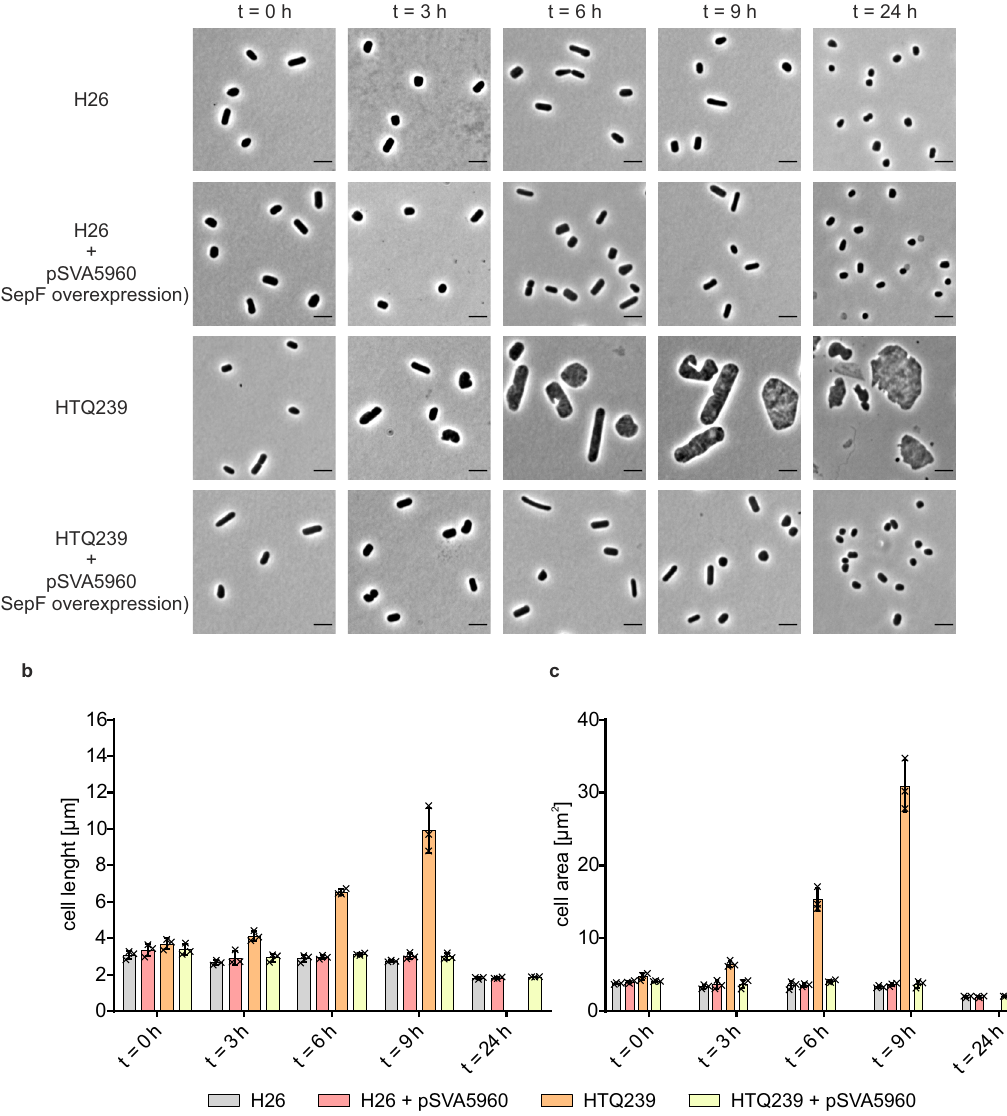
Fig. 6 Cell shape analysis of H26 and HTQ239 during sepF overexpression in the absence of tryptophan. a Microscopy of H26 and HTQ239 cells with or without SepF overexpression plasmid pSVA5960. Cells were imaged in 3 h steps after SepF depletion for 9 h and one last time 24 h after depletion. The experiment was repeated three times independently with similar results. Scale bar: 4 µ m. b Corresponding mean cell length of strain H26 (gray), H26 + pSVA5960 (red), HTQ239 (orange), and HTQ239 + pSVA5960 (yellow) at different time points after SepF depletion. c Corresponding mean cell area at different time points after SepF depletion. Cell shape parameters were obtained from three independent experiments including the cell size of >1000 cells per strain and time point. Error bars indicate the standard deviation, each mean per replication is indicated by a